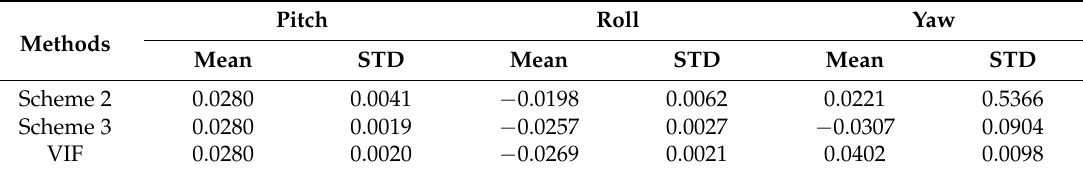
Table 4. The statistics of the alignment errors from 300 s to 400 s ( ◦ ).